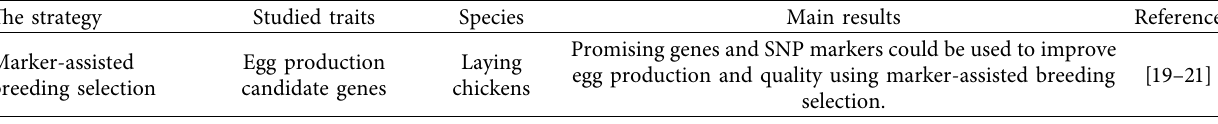
Table 1: Practical breeding, husbandry, and nutritional strategies to improve layer egg production and